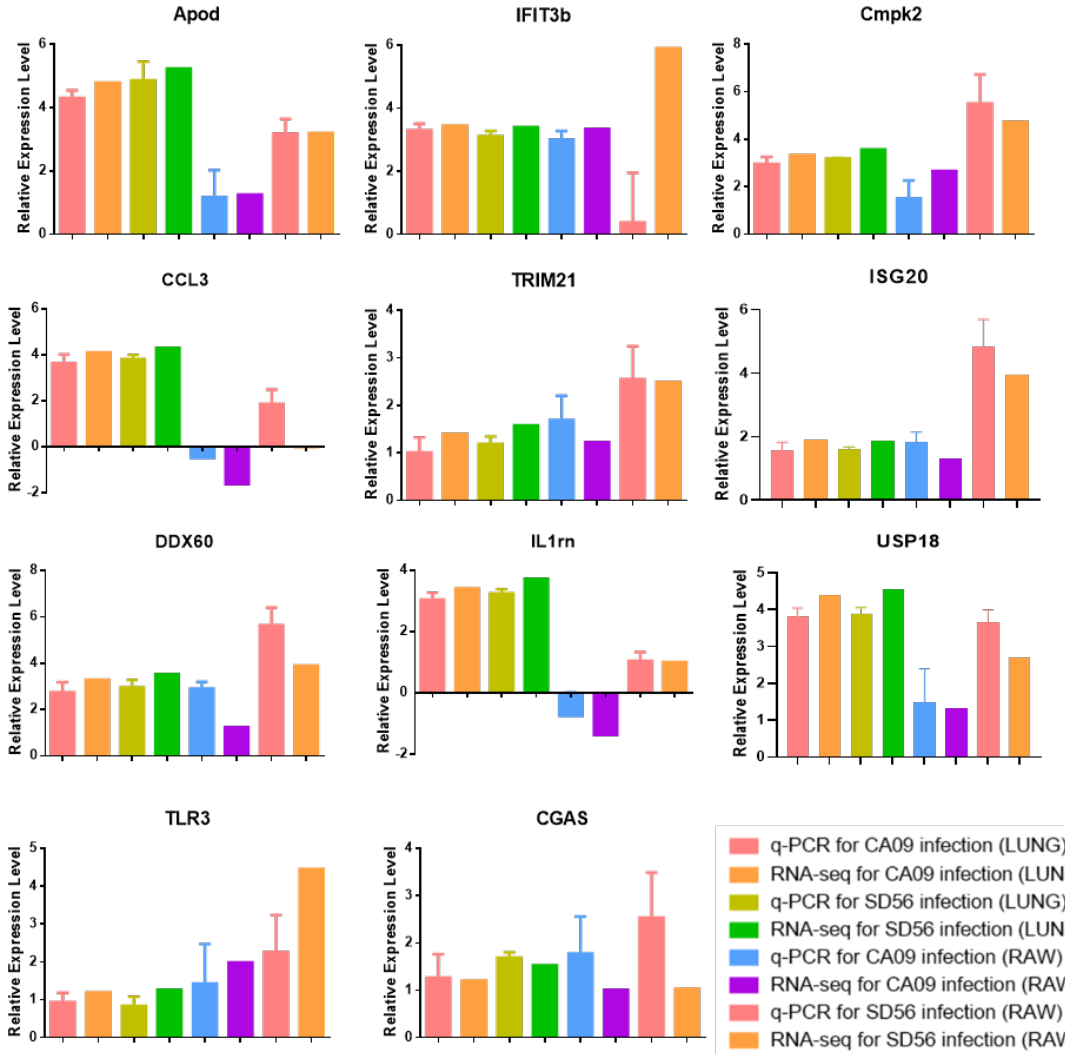
Figure 8. Verification of the relative expression levels using qPCR. Expression levels of selected differentially expressed genes that were associated with IAV infection in the lungs and RAW264.7 cells were measured using qPCR. The expression levels were normalized to the actin expression.